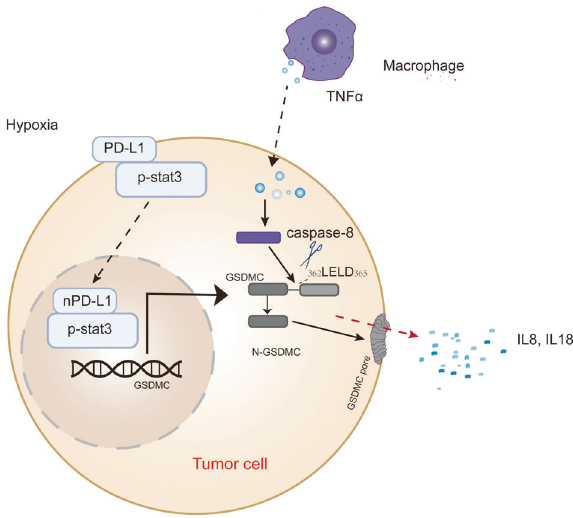
Fig. 2 The mechanism of PD-L1 in pyroptosis. PD-L1 interacts with p-stat3 and then translocate into the nucleus to transcriptionally increase the expression of GSDMC, resulting in pyroptosis in response to hypoxic stress. TNF α in macrophages activates caspase-8, which cleaves GSDMC at the 362 LELD 365 site, releasing N-GSDMC to induce the switch of apoptosis to pyroptosis in cancer